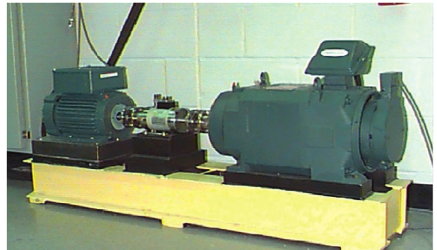
Figure 5: Bearing data acquisition system used by